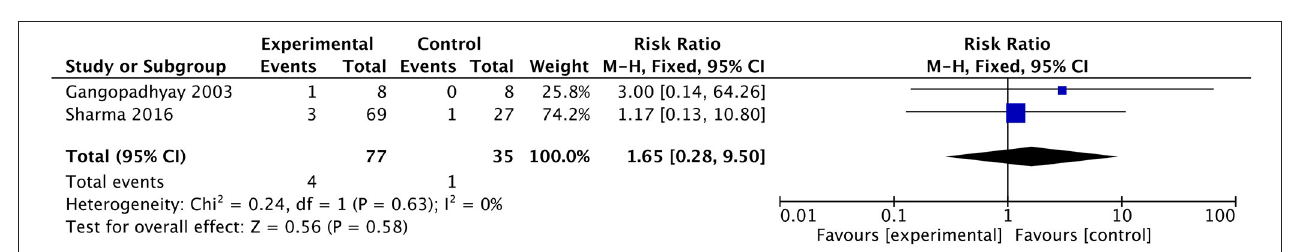
FIGURE 5 | Forest plot for intervention-requiring pneumothorax.